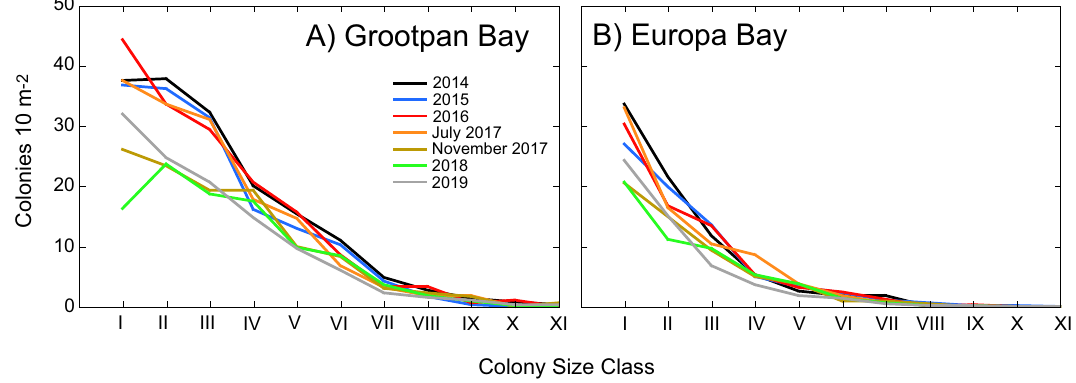
Figure 4. Size-frequency distributions of octocorals at Grootpan Bay ( A ) and Europa Bay ( B ), assessed annually in July of each year as well as November 2017. Frequencies are reported as the number of colonies in 10 m 2 , pooled among taxa. Size Class I = < 10 cm, II: ≥ 10 cm and < 20 cm, III: ≥ 20 cm and < 30 cm, IV: ≥ 30 cm and < 40 cm. V: ≥ 40 cm and < 50 cm, VI: ≥ 50 cm and < 60 cm, VII: ≥ 60 cm and < 70 cm, VIII: ≥ 70 cm and < 80 cm, IX: ≥ 80 cm and < 90 cm.